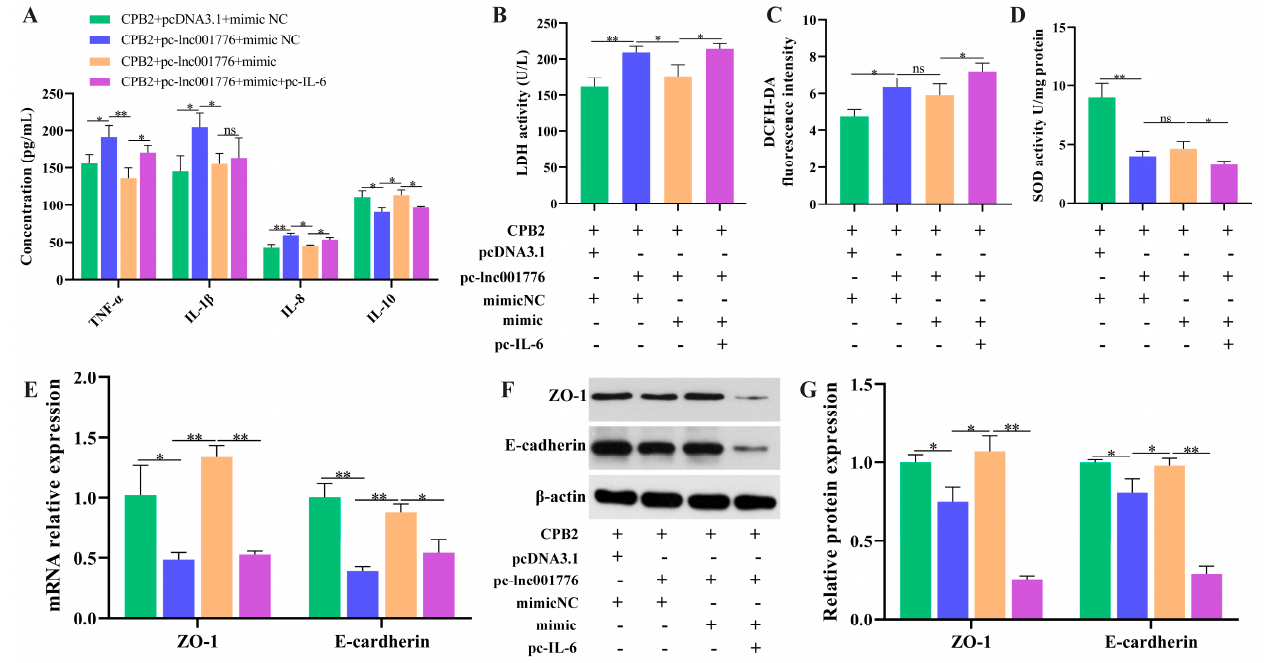
Figure 10. Elevated lnc001776 enhanced CPB2 toxin-triggered inflammatory injury and barrier dysfunction in IPEC-J2 cells via ssc-let-7i-5p/ IL-6 axis. ( A ) TNF- α , IL-1 β , IL-8 and IL-10 levels via ELISA. ( B ) LDH activity. ( C ) ROS level. ( D ) SOD activity. ( E ) ZO-1 and E-cadherin mRNA expression through RT-qPCR. ( F , G ) ZO-1 and E-cadherin protein expression through Western blot. ns: not significant. * p < 0.05, ** p < 0.01.